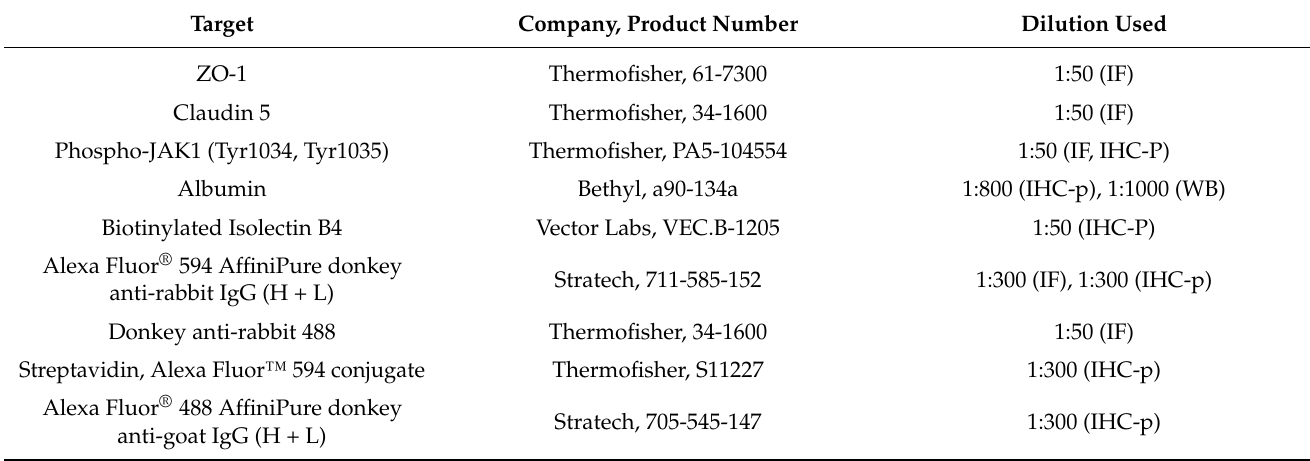
Table 1. Antibodies used for